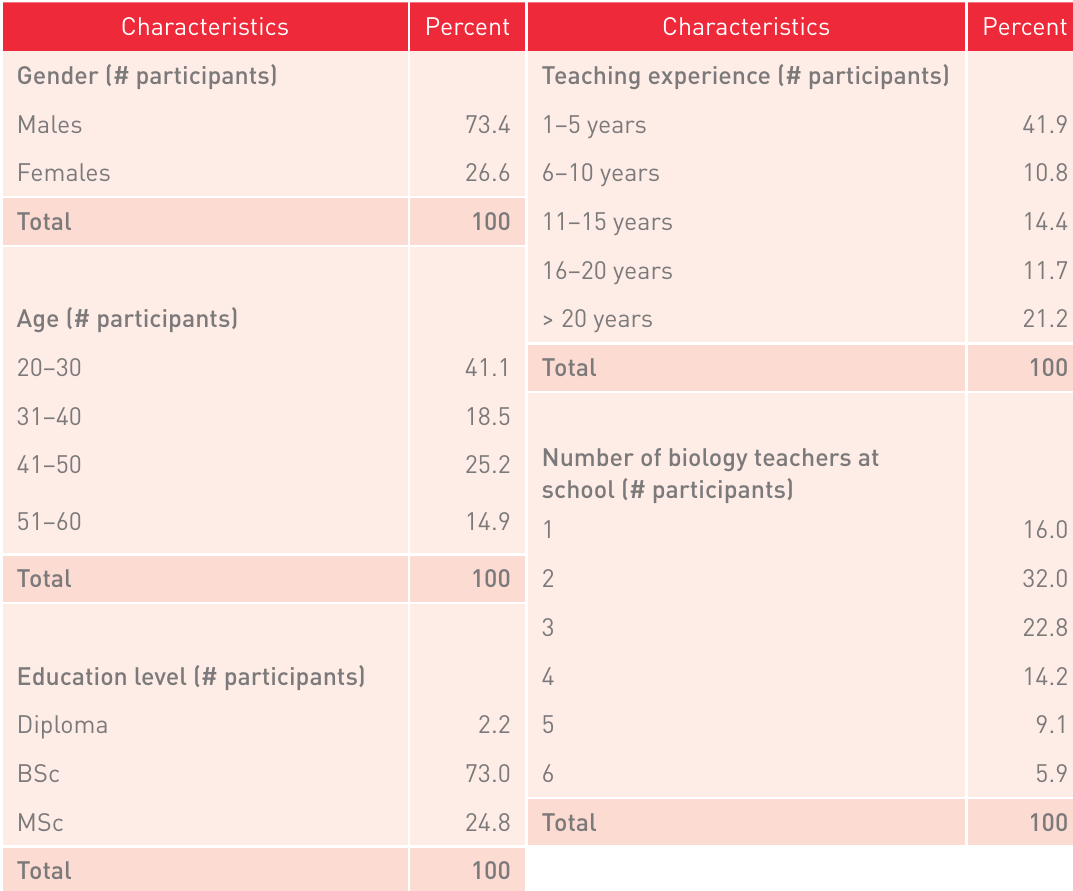
Characteristics of the participants